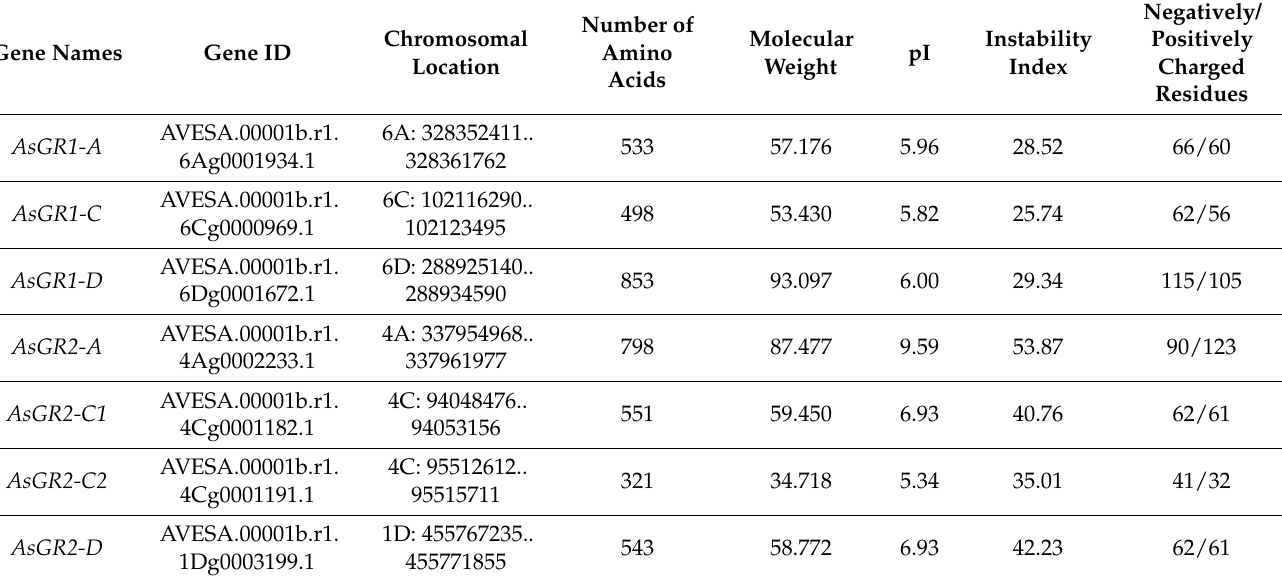
Table 1. Physico-chemical properties of GR family in A. sativa